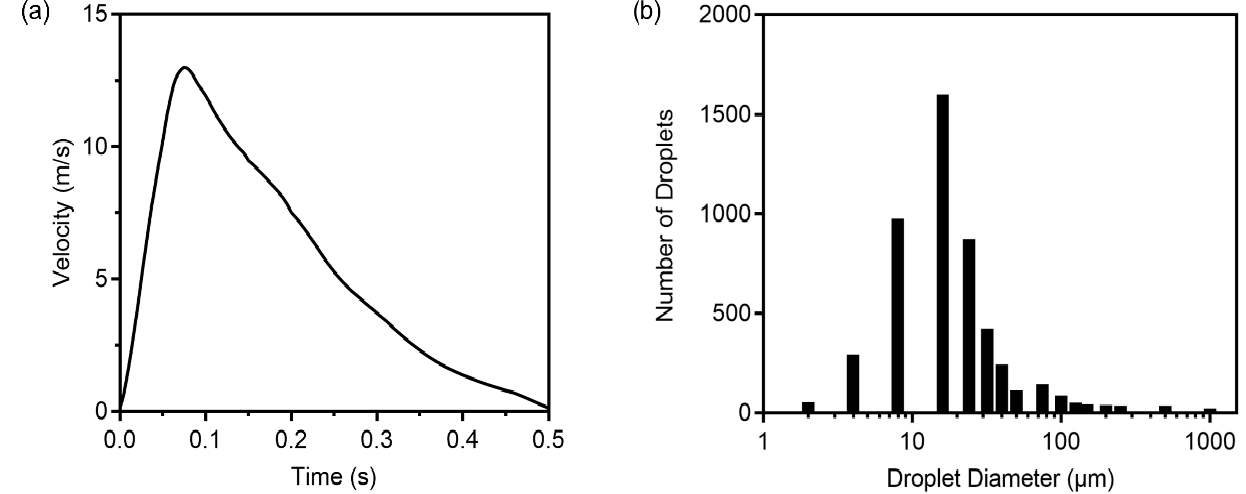
Figure 3. ( a ) Airflow velocity of droplets from a single cough; ( b ) Cough droplet size